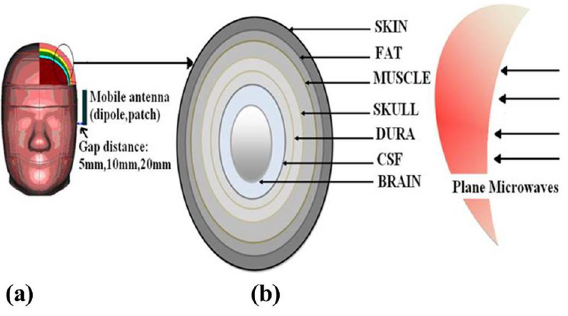
Figure 1. The Model of a human head. (a) Cross section human head model with mobile phone. (b) Plane microwaves irradiating a cranial model composed of seven layers.